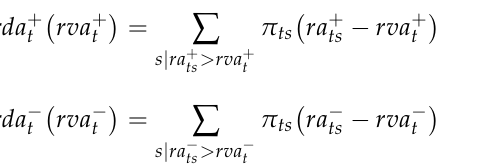
Figure 6. For simplicity, variables rd +